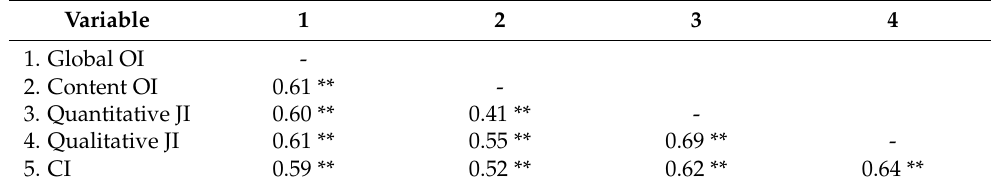
Table 3. Correlation table of study variables to demonstrate convergent